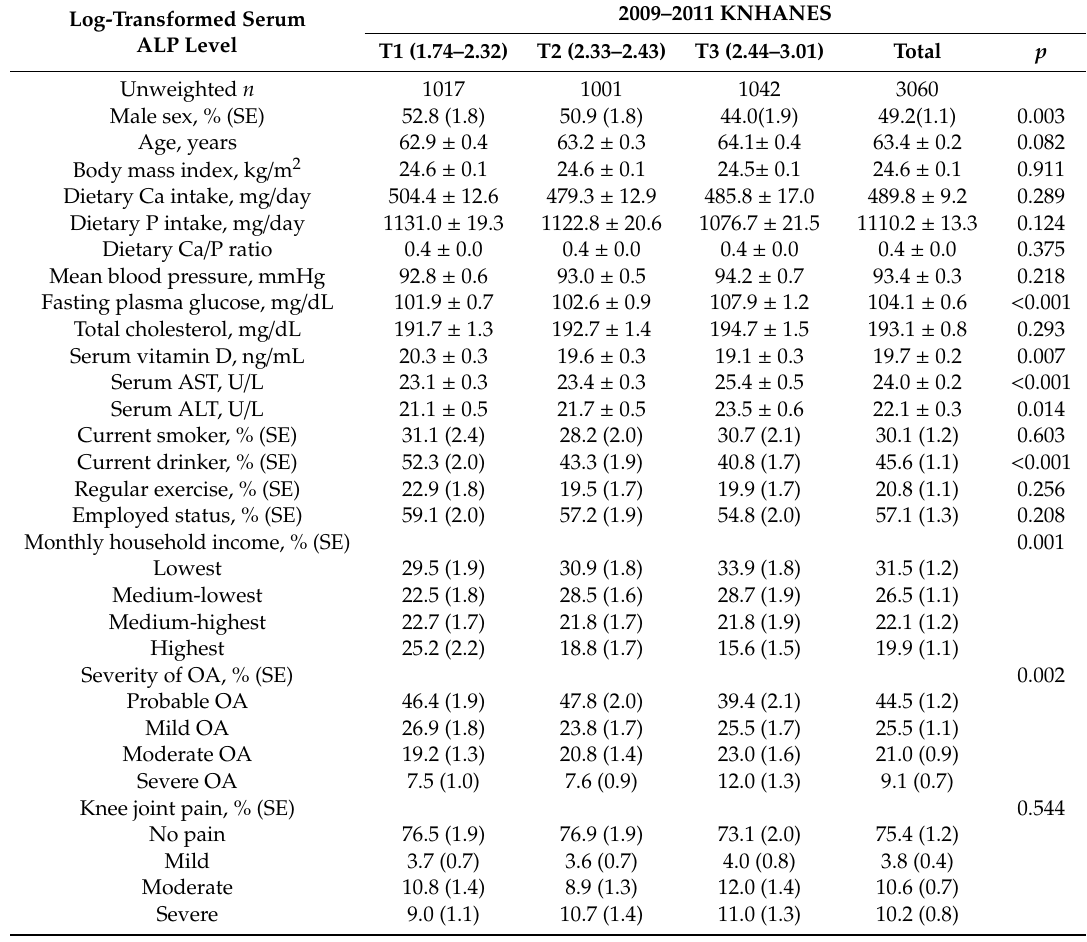
Table 1. Clinical characteristics of the study